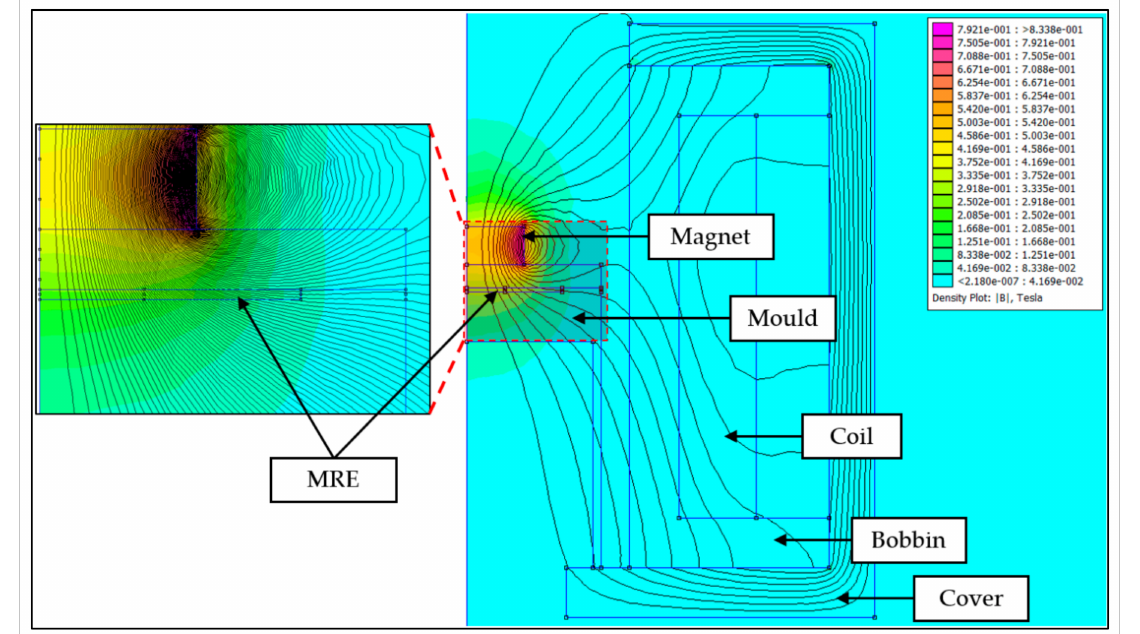
Figure 3. Simulation through FEMM showing the flux line generated from the apparatus.